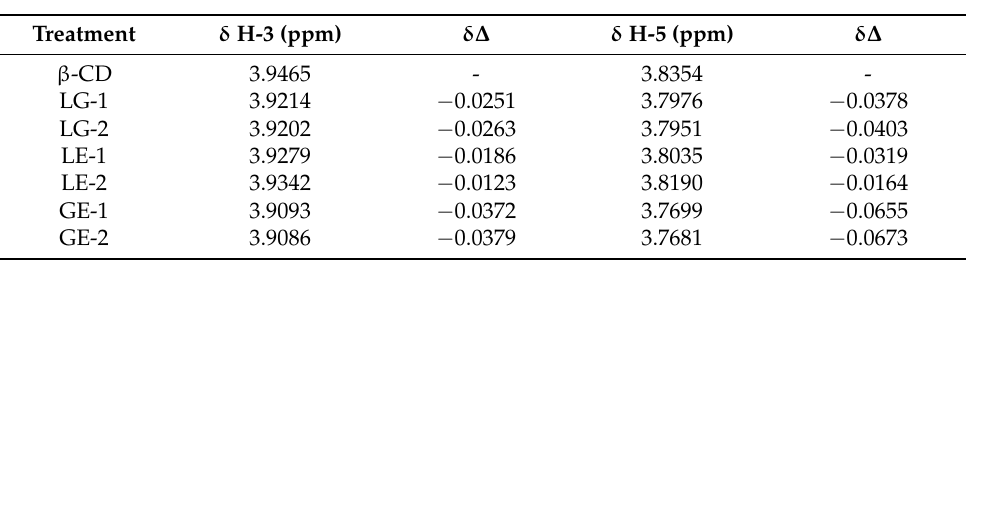
Table 4. Chemical shift ( δ ) and change in chemical shift ( ∆ δ ) of H-3 and H-5 of β -cyclodextrin and inclusion complexes. Protons are labeled according to Figure 7 of the repeating unit of β